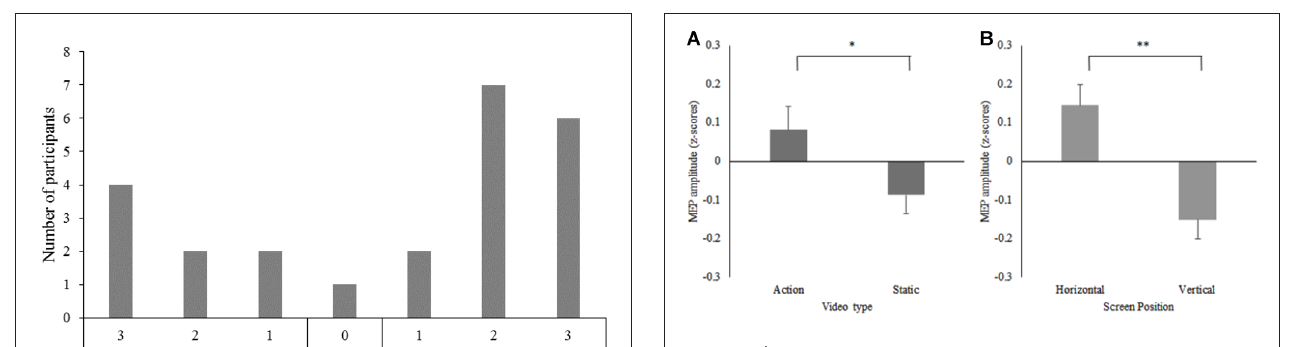
FIGURE 4 | Mean MEP amplitudes displayed as z -scores from the horizontal preference group, for (A) the action and static conditions ( ∗ p = 0.01) and (B) the horizontal and vertical screen positions ( ∗∗ p = 0.03) for the right FDI